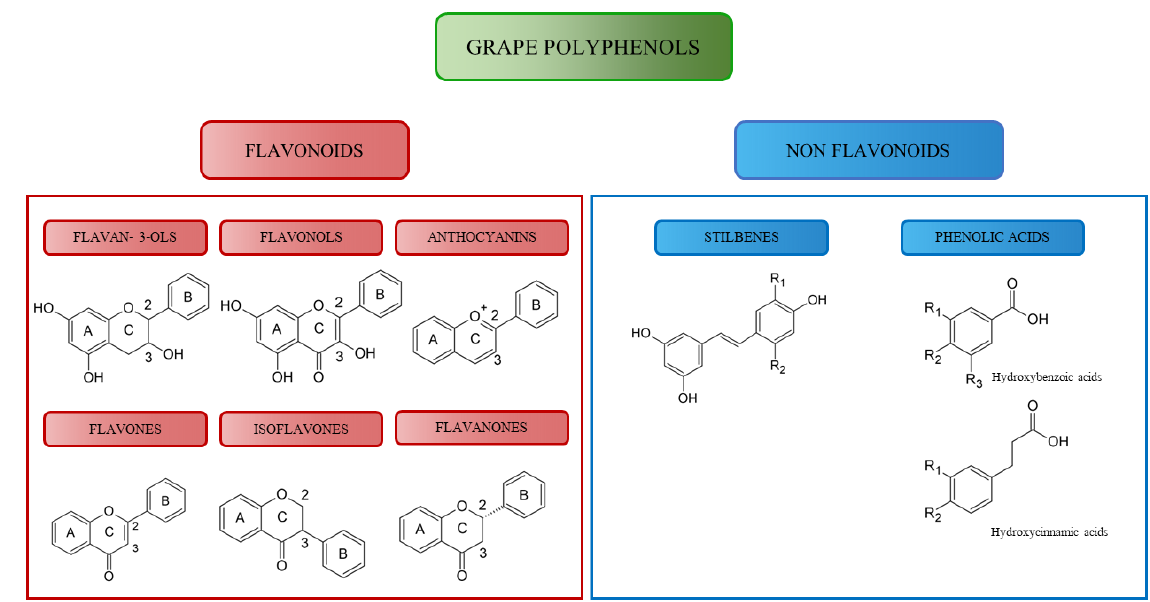
Figure 2. Polyphenols